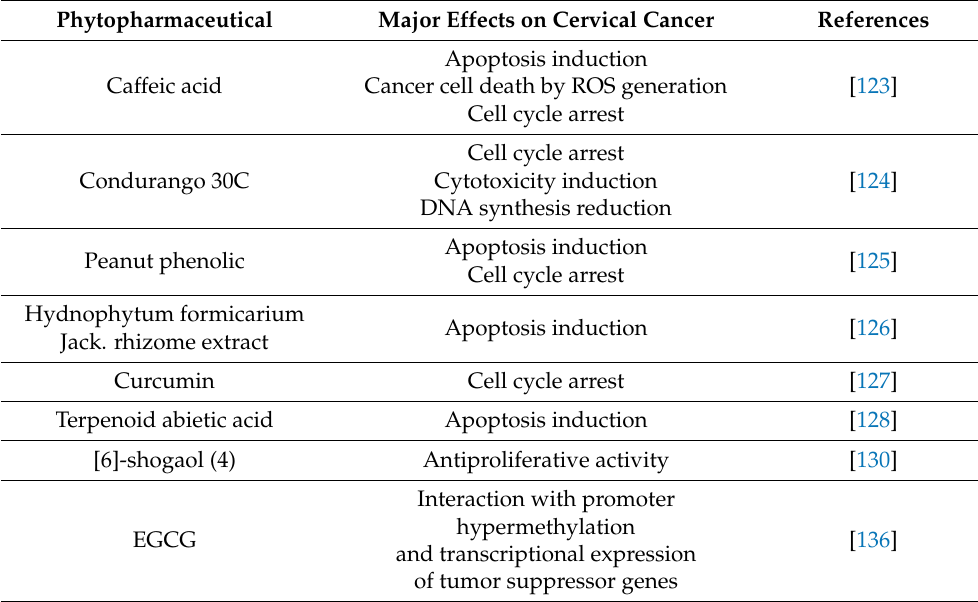
Table 3. Major effects of phytopharmaceuticals as monotherapies on cervical cancer. Phytopharmaceutical